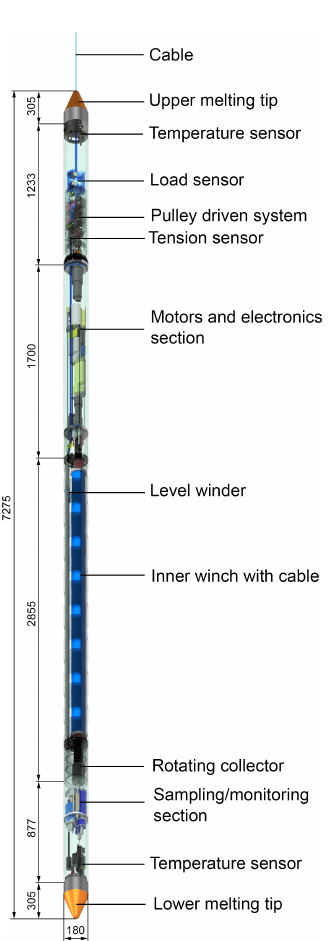
Figure 2. 3D model of the RECAS working prototype with a 500m long cable inside (sonde body is shown transparent; all dimensions are in